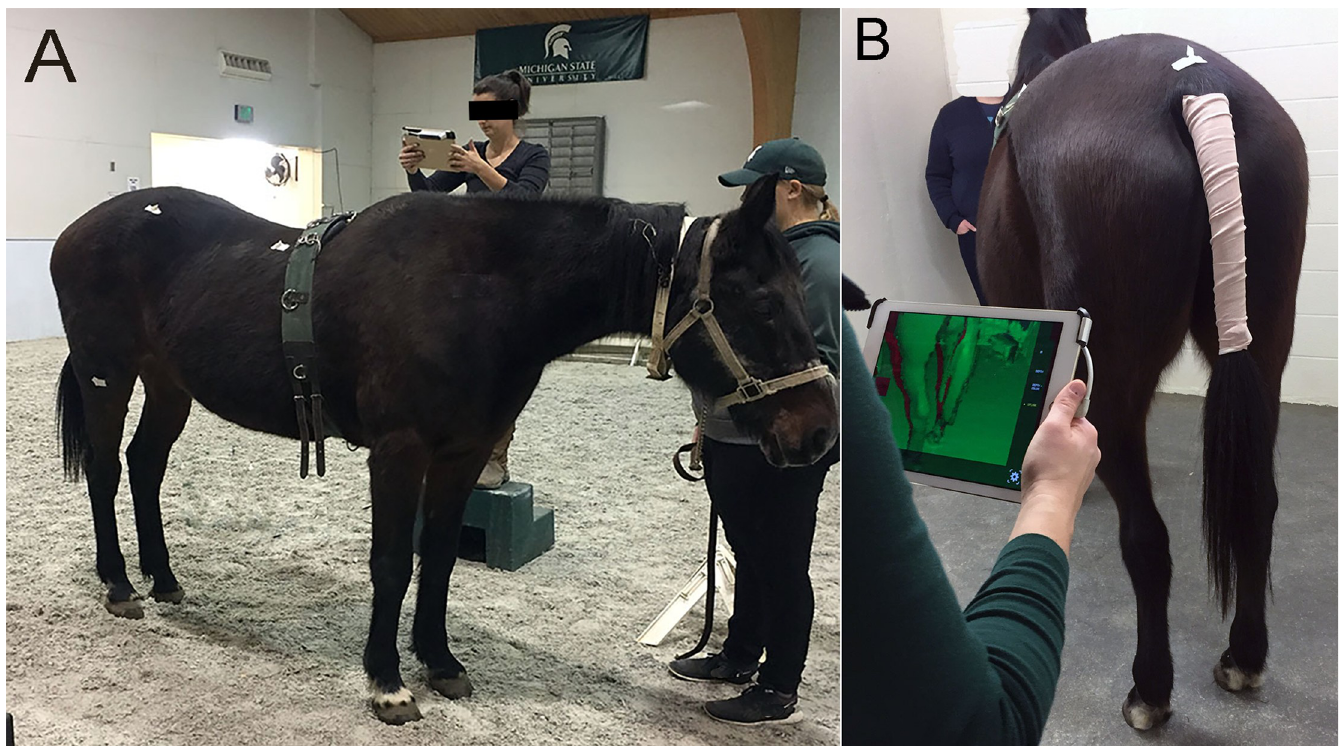
Fig 1. 3D scanning process. A. Positioning of the horse for obtaining a 3D scan using an iPad with occipital structure sensor scanner and surcingle with anatomic markers. B. Diagonal position of the horse for scanning in a stall and screen view of the scanning